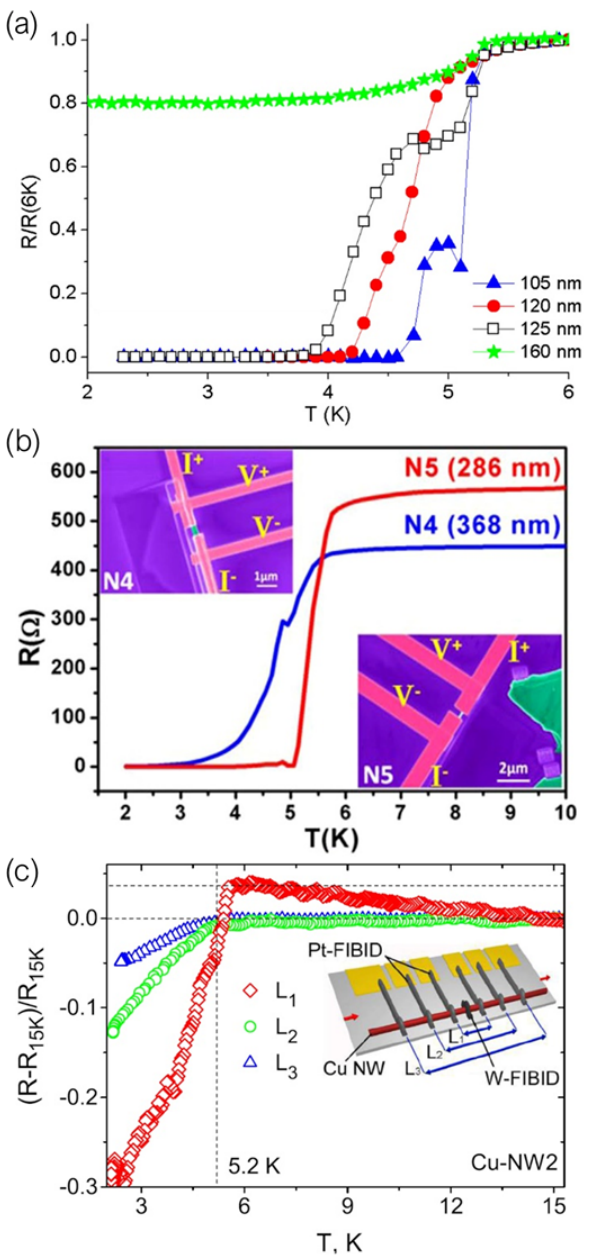
Figure 4. ( a ) Resistance, normalized at its value at 6 K, as a function of temperature for W-C— bismuth nanostripes—W-C devices with inner probe distances of 105 nm, 120 nm, 125 nm, and 160 nm. Adapted from [97], with permissions from IOP Publishing. ( b ) Resistance as a function of temperature for W-C—Bi 2 Se 3 —W-C devices N4 and N5, with junction lengths 368 nm and 286 nm, respectively. Insets show false-colored SEM micrographs of the devices with Ga + FIBID W-C su- perconducting electrodes in pink and Bi 2 Se 3 nanowires in green. Reprinted from [98], under CC BY license. ( c ) Relative change in resistance, normalized at its value at 15 K for single-crystal Cu nanowires with an inner Ga + FIBID W-C superconducting inducer electrode. Resistance measure- ments were performed by probing different lengths between 2 µ m and 12 µ m. The inset shows the scheme of the electrical contacts used for the resistance measurements. Reprinted from [99], with permissions from AIP